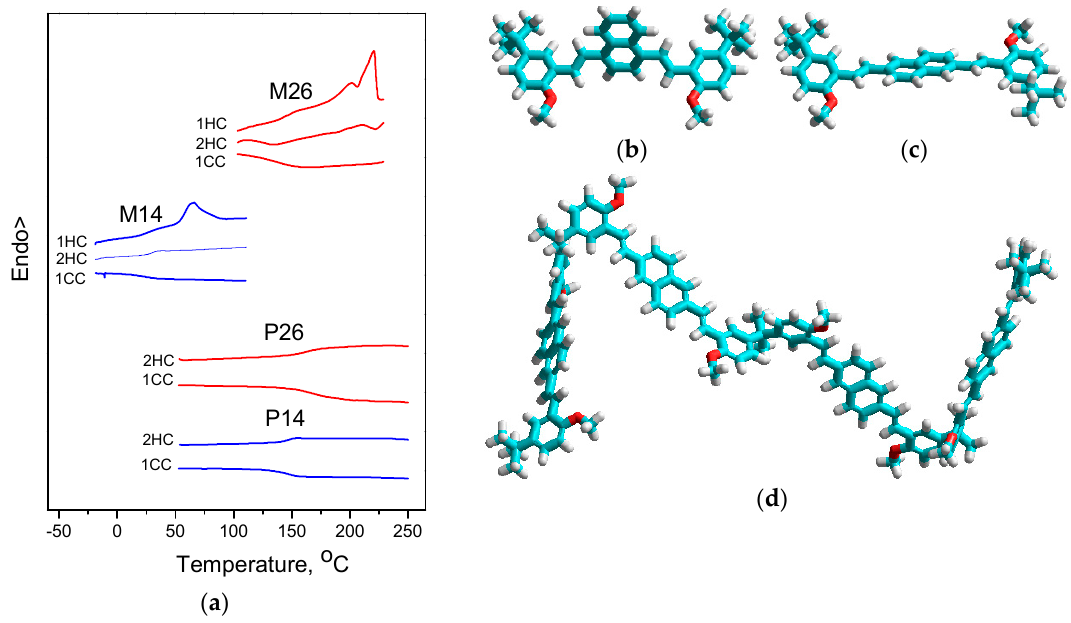
Figure 2. ( a ) Differential scanning calorimetry (DSC) traces of model compounds and polymers. ( b ) DFT/PBEh-3c relaxed geometry of M14 , ( c ) M26 and ( d ) a tetramer of P26 .